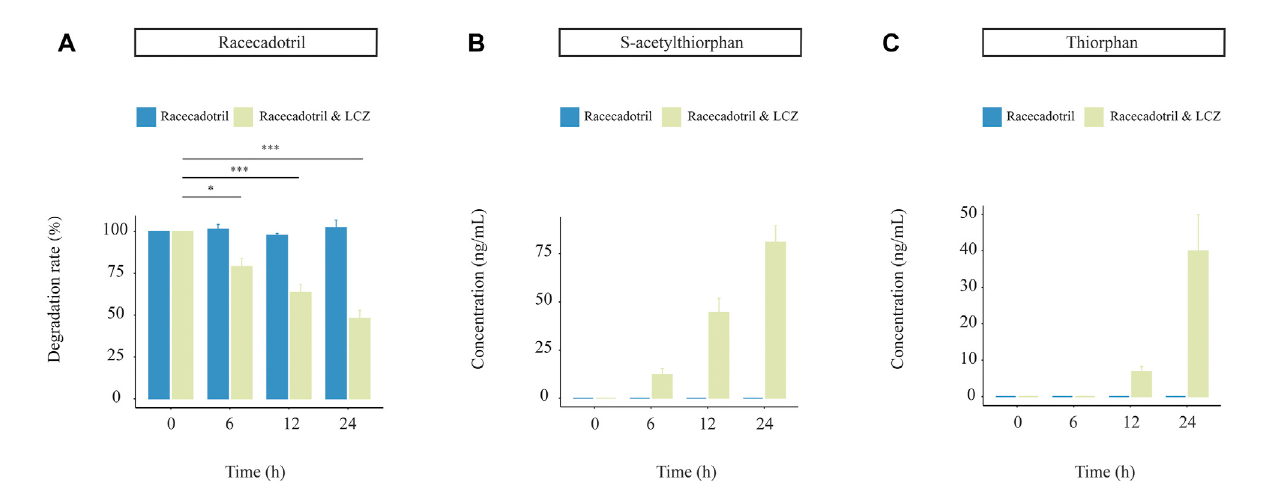
FIGURE 3 Drug-metabolizingactivitiesof L.casei Zhang(LCZ)inanear-realhumandigestionsystem(DHS-IV). (A) racecadotriland (B,C) changesinconcentrations ofs-acetylthiorphan andthiorphanatdifferenttime pointsafterdigestioninthe invitro human simulateddigestion systeminthepresenceorabsence ofLCZ. The drug and metabolites were detected by targeted metabolomics. Error bars represent SD. *** p < 0.001, * p < 0.05, Wilcoxon test.